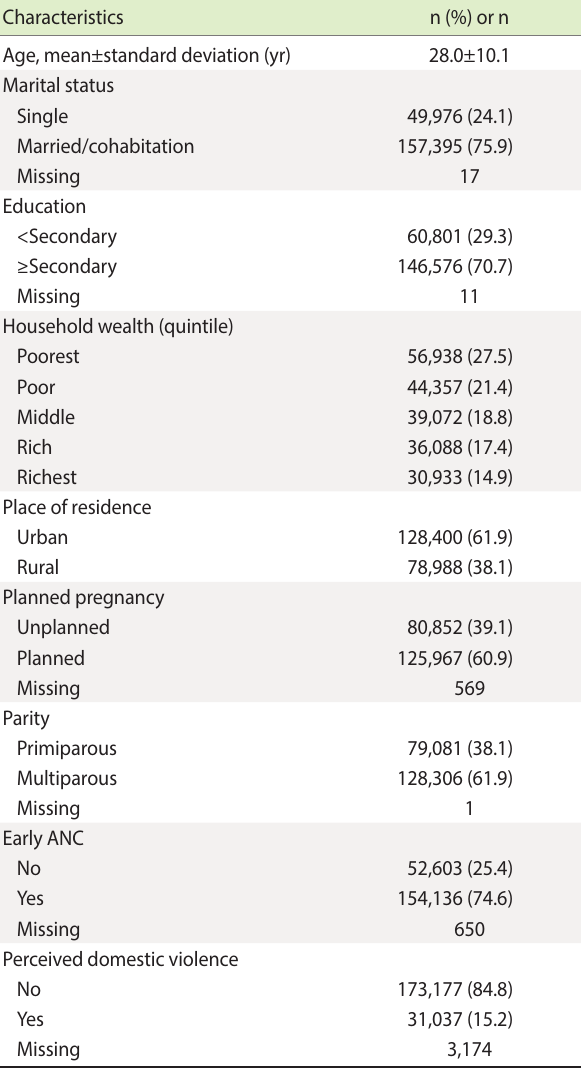
Table 1. Characteristics of the study population across 30 low-and middle-income countries (n=207,388)